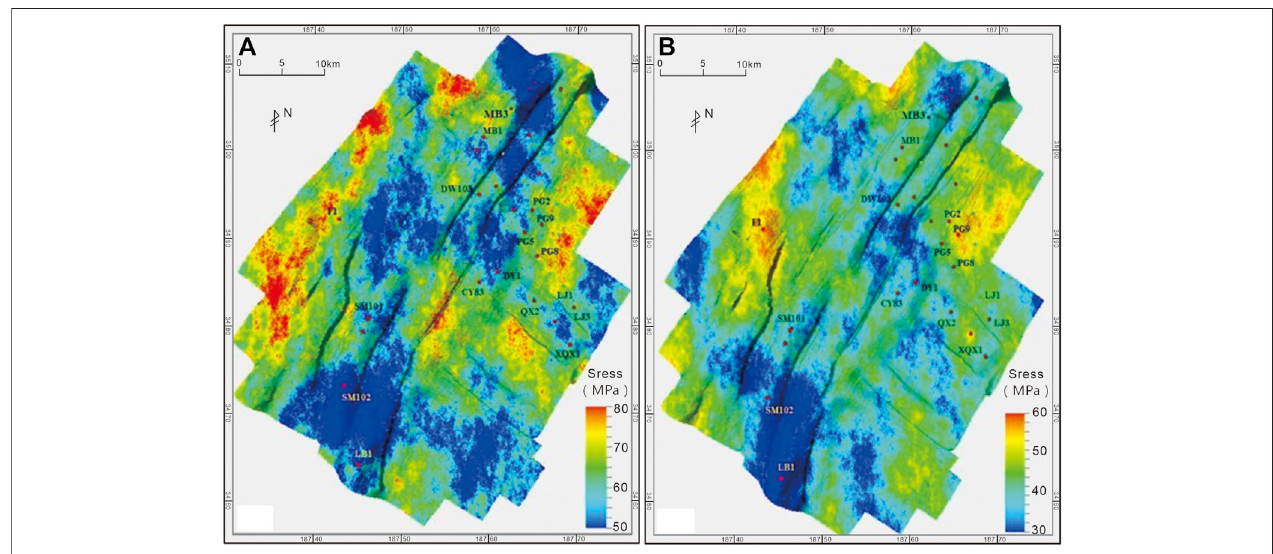
FIGURE 4 | The contour maps of the numerical simulation geo-stress in the second member of Jialingjiang formation, Puguang area (A) the maximum horizontal principal stress (B) the minimum horizontal principal stress.